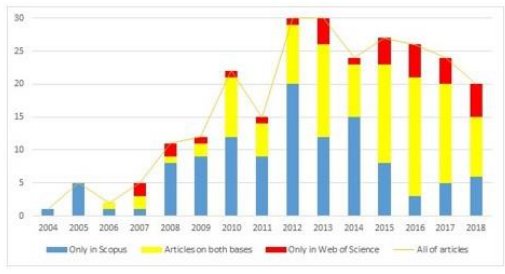
Figure 3. BoP Literature Development based on Data from Scopus and Web of Science